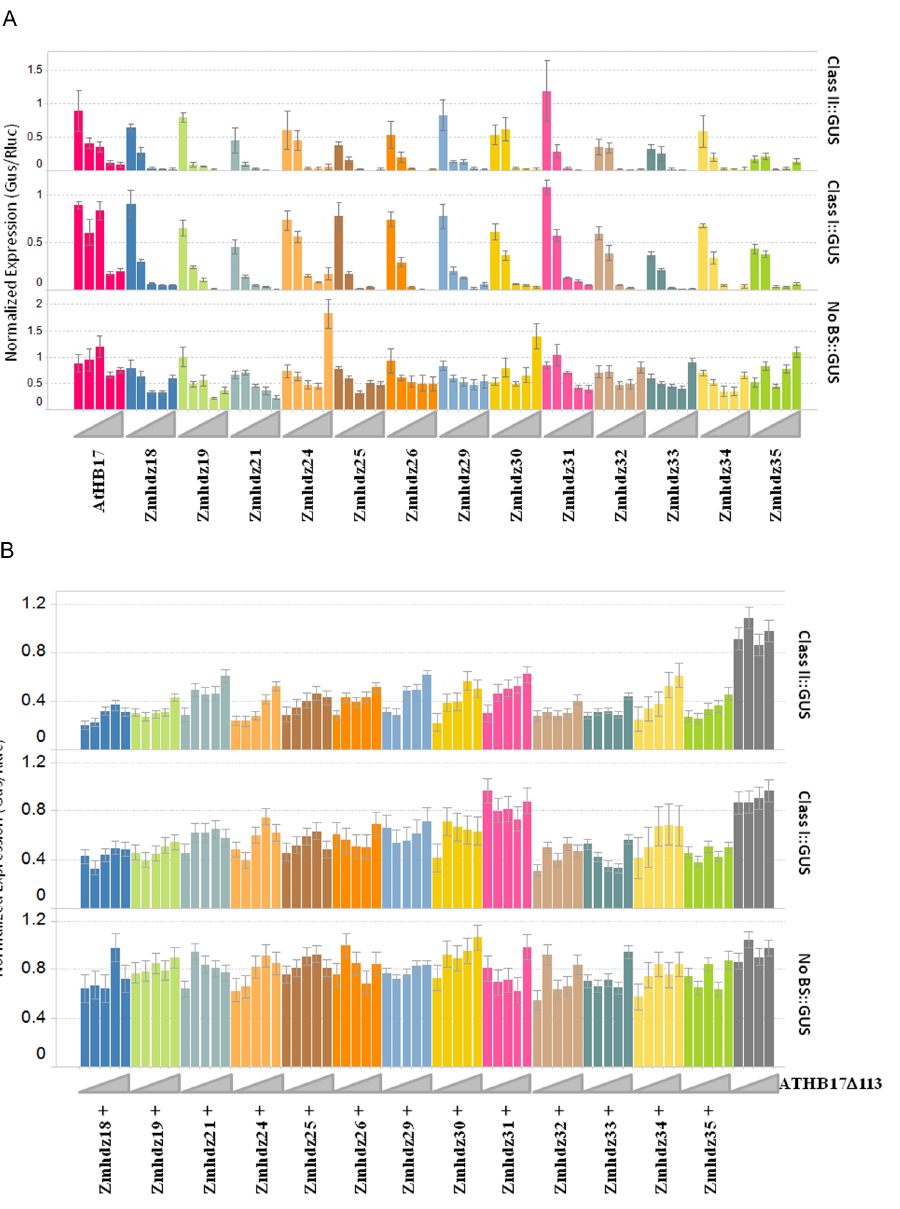
Figure 8. Maize HD-Zip II proteins function as transcriptional repressors and ATHB17 D 113 relieves the repression caused by endogenous maize HD-Zip II proteins. (A) Cells were co-transformed with 4 m g/320,000 cells of each reporter (right side label) and an increasing amount of each HD-Zip II family member (left-to-right for each color: 0.008; 0.04; 0.2; 1; 5 m g/320,000 cells). Error bars are 1 SD. (B) Cells were triple- transformed with 4 m g/320,000 cells of each reporter (right side label), 20 ng of each HD-Zip family member and an increasing amount of ATHB17 D 113 (left-to-right for each color: 0.0, 0.3; 0.6; 1.3; 2.5 m g/320,000 cells). For a given reporter, HD-Zip II, and concentration of ATHB17 D 113, the calculation of standard error relies on the number of biological replicates and the estimated error variance derived from a one-way